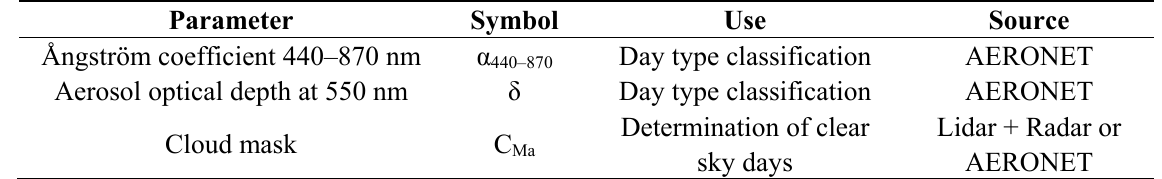
Table 1. Data used in the present study to select clear sky dates and to classify them into day